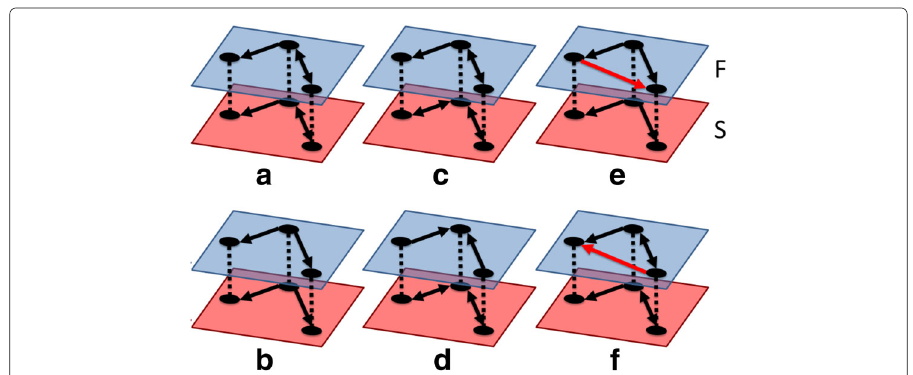
Fig. 4 Triadic Transformations. Examples of triadic transformations. ( a ) and ( b ) show triad-preserving transformations for triads 8 and 4, respectively. ( c ) shows the transformation from triad 11 to triad 8 and ( d ) is the transformation from triad 11 to triad 5. ( e ) transforms triad 4 to 9 and ( f ) transforms triad 8 to 13. Both ( e ) and ( f ) demonstrate the addition of a false-positive (FP) (red edges are FP). All vertices are treated as